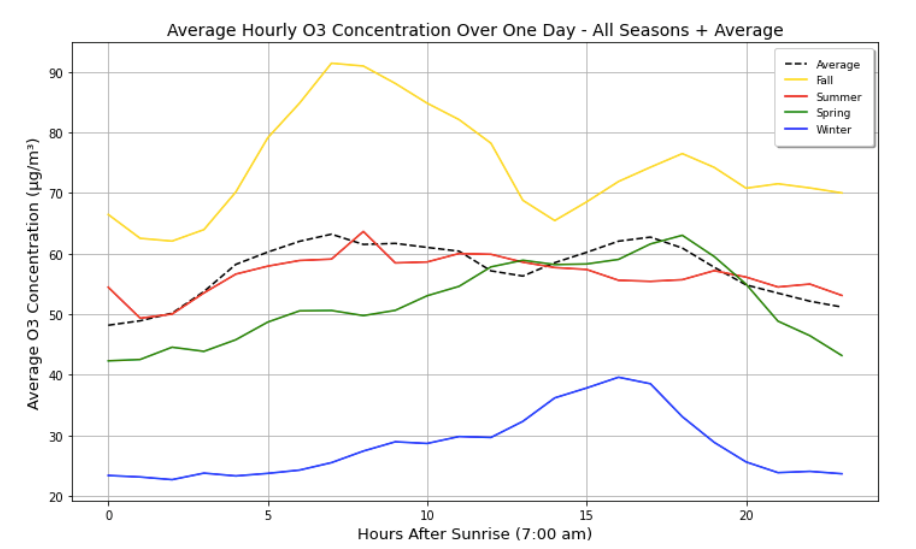
Figure 7. Average hourly O 3 concentration over one day for all seasons, showing elevated ozone in the fall and low values in winter. Ozone production requires solar radiation, which causes peaks during the day and a drop at